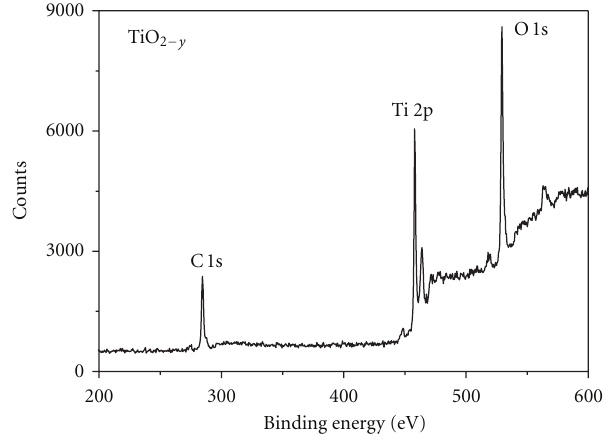
Figure 6: Typical overall XPS spectrum for a TiO 2 − y thin film deposited by reactive sputtering onto Si